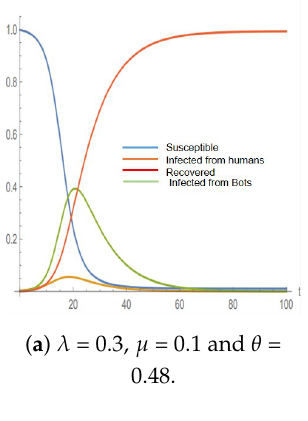
Figure 5. The simulation results for the SI h I b R model using different rates on the 2011 dataset (a is the best